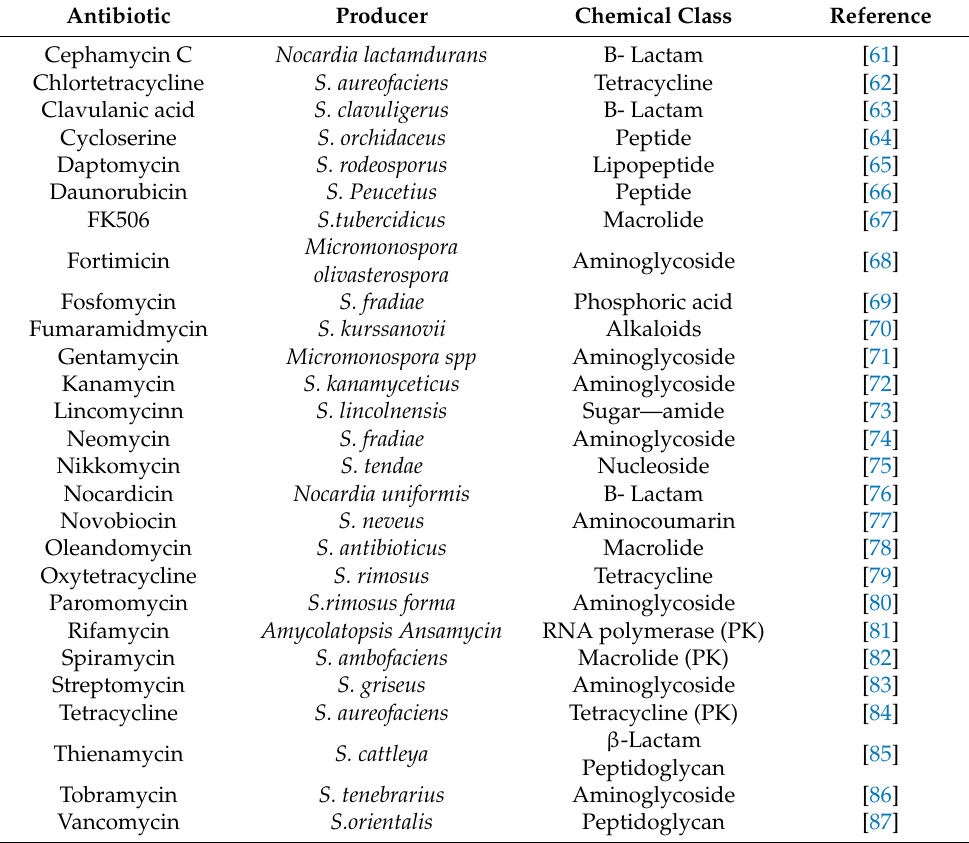
The list of important producers and chemical classification of antibiotics isolated from